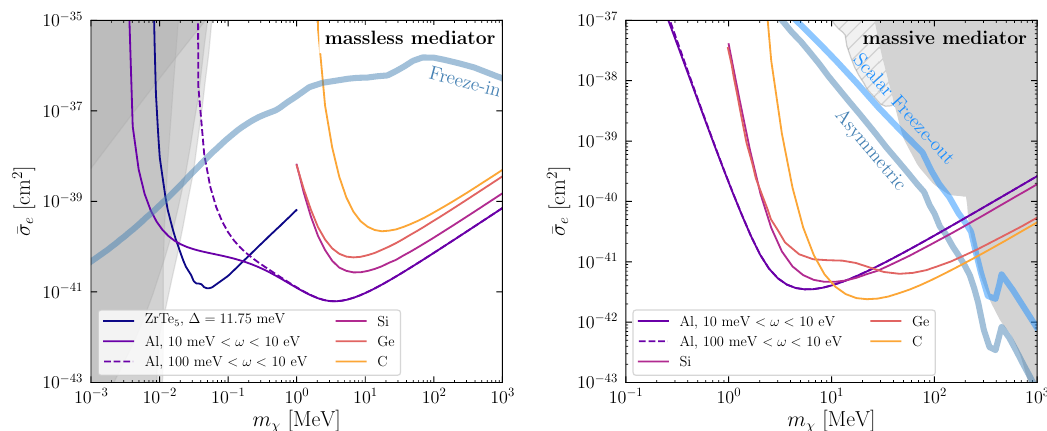
Figure 7: Reach to DM-electron cross section in different solid state targets for scat- tering through a light mediator (left) and heavy mediator (right), assuming kg-year exposure and zero background. Diamond (C) gives an example of a somewhat high = 5.5 eV; the reach shown is from Ref. [ 47 ] . Si and Ge have O(eV) gap target E gap gaps and have been studied extensively as target materials. The reach for Ge with a massless mediator and Si in both cases is from Ref. [ 45 ] . For Ge and a massive me- diator, the reach shown is from Ref. [ 48 ] ; for DM masses above ∼ 20 MeV, the reach is dominated by the excitation of semi-core electrons. For sub-MeV DM, lower gap materials are needed and we show projections for an example Dirac material from Ref. [ 49 ] and for Al from Refs. [ 45,46 ] . In the left plot, the thick blue line is the pre- dicted cross section if all of the relic DM is produced by freeze-in interactions [ 9,33 ] and the shaded regions are constraints from stellar emission [ 8, 50 ] . In the right plot, the thick blue lines are cross sections for freezeout of scalar DM or fermionic asymmetric DM [ 38 ] ; note that for asymmetric DM, the line is a lower bound and cross sections above it also satisfy relic density and CMB annihilation considerations. The shaded region shows combined direct detection bounds (solid grey) and model- = 3 m dependent accelerator bounds when the dark photon mass is m χ (hatched A (cid:48) grey) [ 51 ] . All bounds and relic density lines assume a dark photon